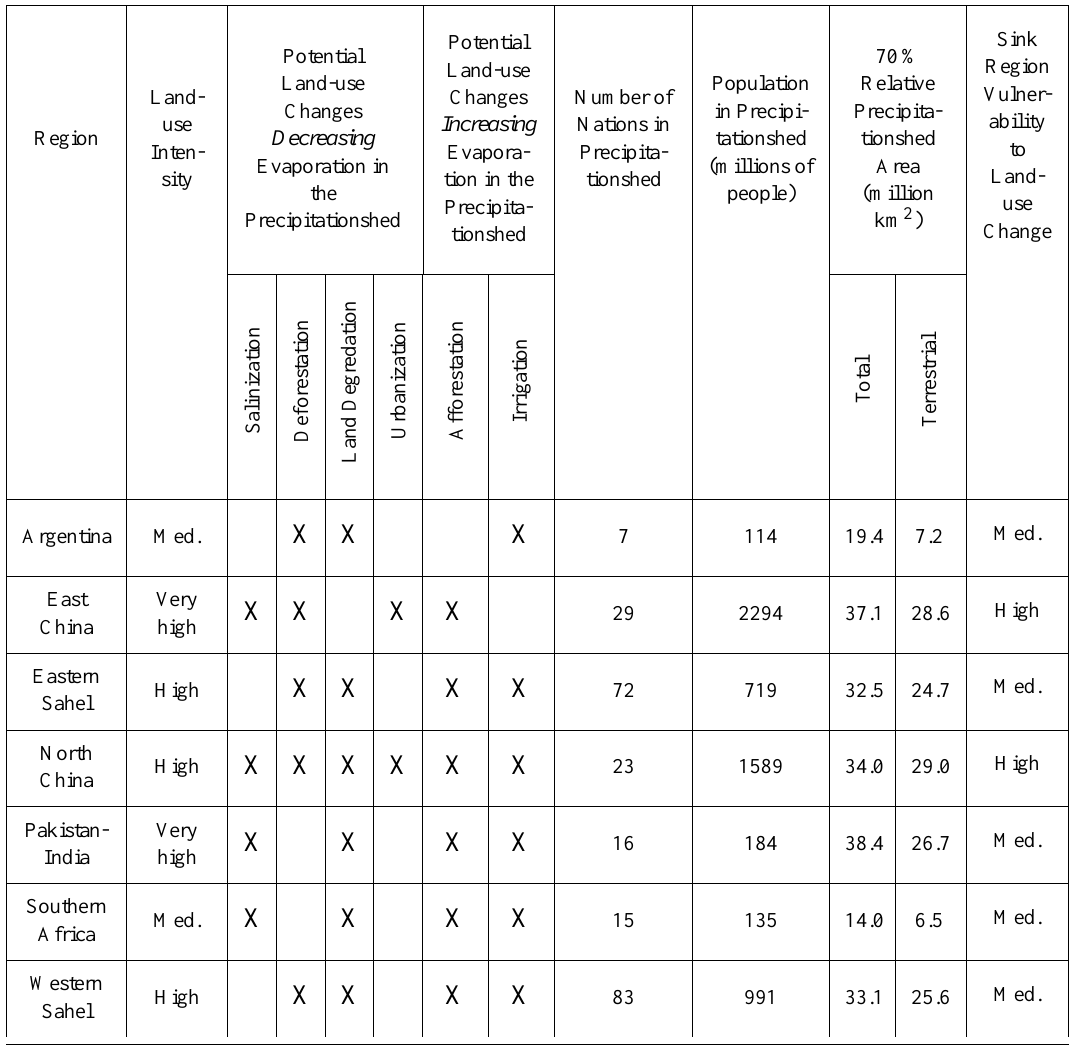
Table 4. Analysis of the vulnerability of the sink regions to land cover changes in the precipitationsheds, in terms of (a) current land-use intensity, (b) whether land cover change is expected to increase/decrease precipitationshed evaporation, (c) the number of countries in the precipitationshed, and (d) the spatial size of the